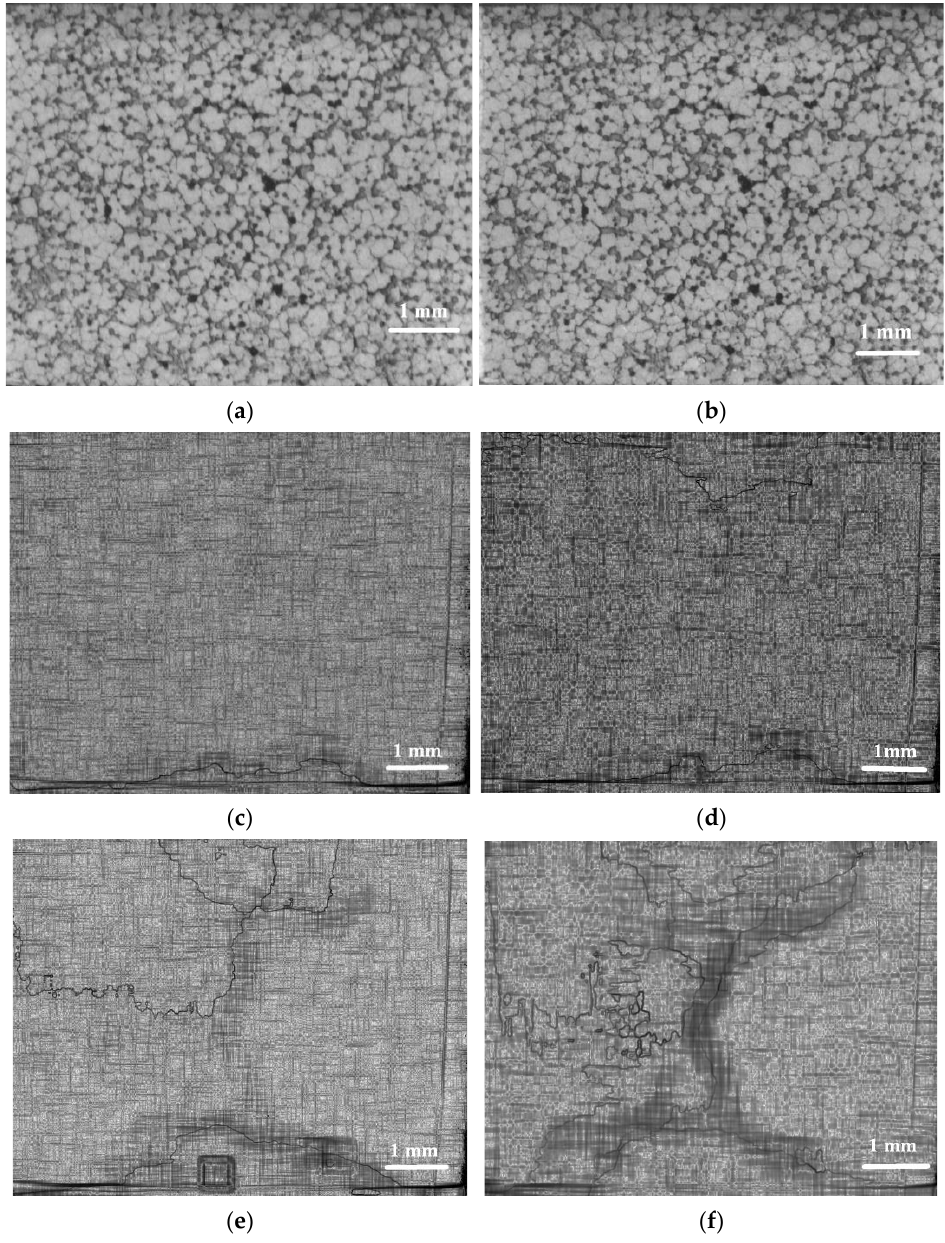
Figure 6. Optical macrographs ( a , b ) and deformation maps ( c-f ) of Sample #4 at the deformation Stage I at strain are as follows: ε = 0.000 ( a ), ε = 0.024 ( b ), ε = 0.0076, ∆ ε = 0.0025 ( c ), ε = 0.011, ∆ ε = 0.0025 ( d ), ε = 0.015, ∆ ε = 0.0038 ( e ), and ε = 0.024, ∆ ε = 0.0063 ( f